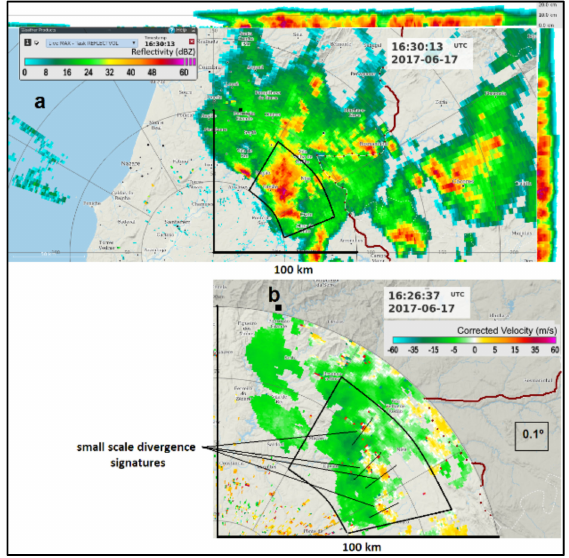
Figure 6. ( a ) MAXZ at 16:30 UTC, 17 June 2017, C/CL radar. Range rings are marked every 50 km. Segments mark the 100-km range. Fire areas are represented by a black square symbol. An azimuthal sector (50–80-km range) in the north–eastern quadrant where high reflectivity cores were observed is also defined. Around the upper and right borders of the central image, the side panels of MAXZ are represented. ( b ) Zoomed-in area from ( a ) extracted from the Doppler scan, storm-relative velocity PPI, 0.1 ◦ tilt at 16:26 UTC, 17 June 2017. Small radial segments depict small-scale divergence signatures coherent with discrete downburst activity. Border with Spain is represented by the brown